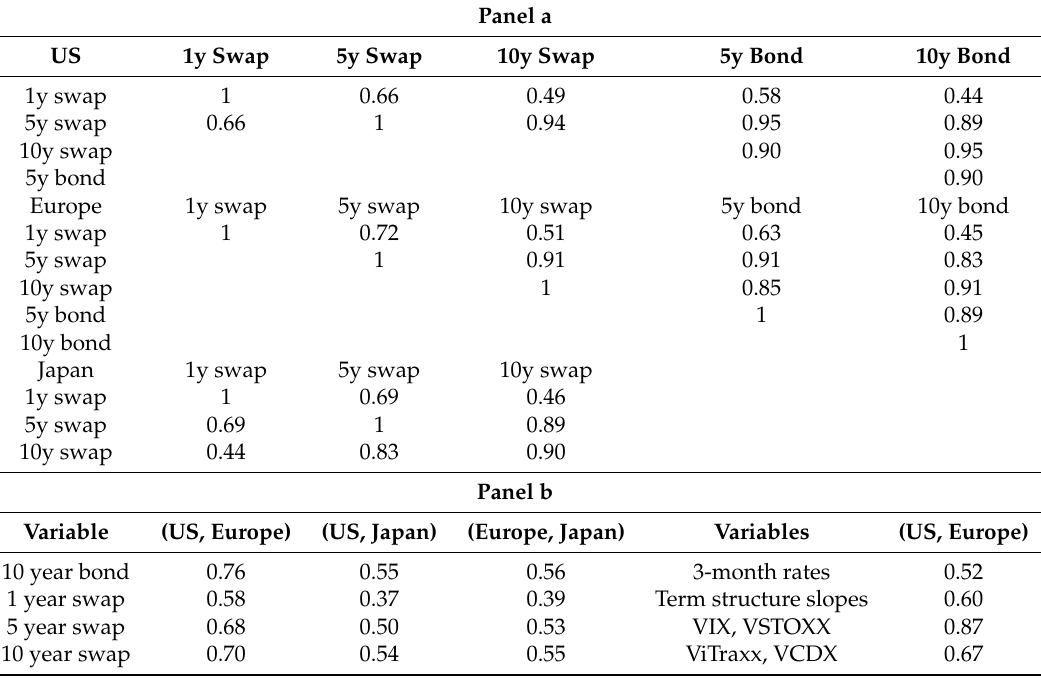
Table 18. Correlation among financial risk indicators. Panel